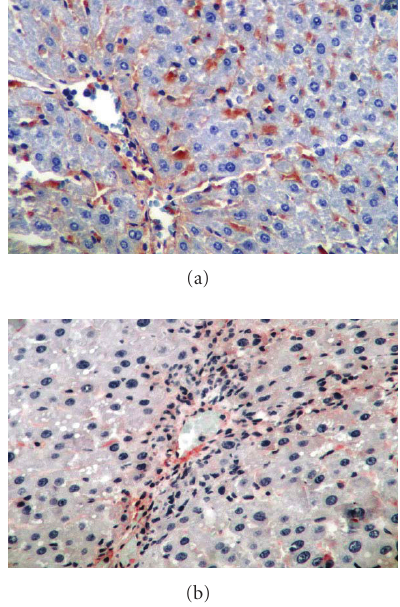
Figure 3: (a) Group 4: actine expression was increased in group 4 (x400); (b) group5: actine expression was decreased in group 5